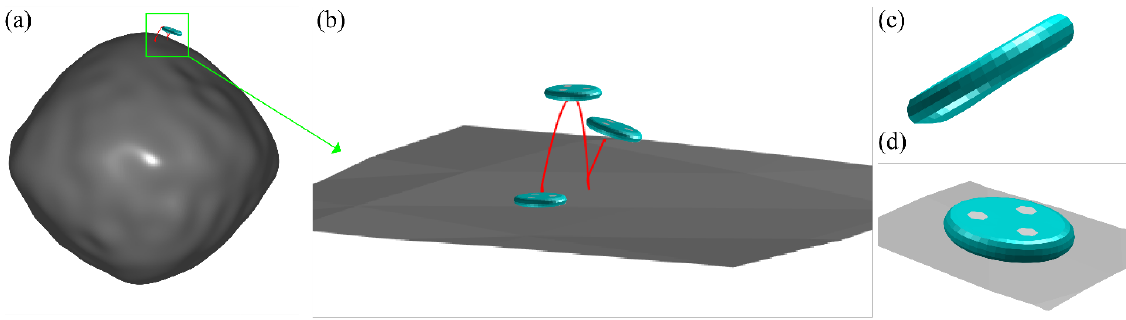
Figure 9. ( a ) The flexible lander on the asteroid; ( b ) the movement of the flexible lander on the as- teroid; ( c ) the first collision at 17 s; ( d ) the flexible lander completing a stable landing.